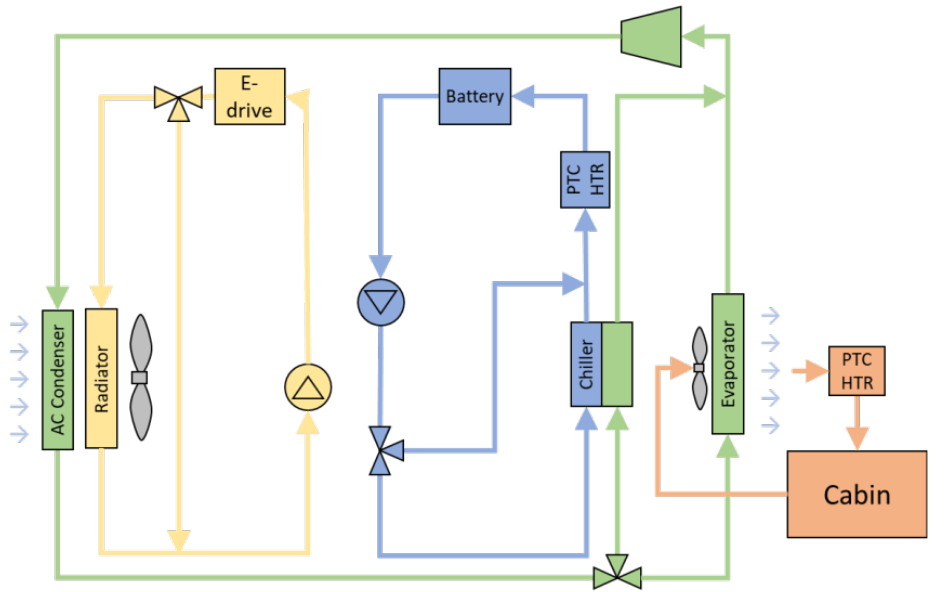
Figure 2. Integral thermal management system of the electric bus: Baseline configuration.